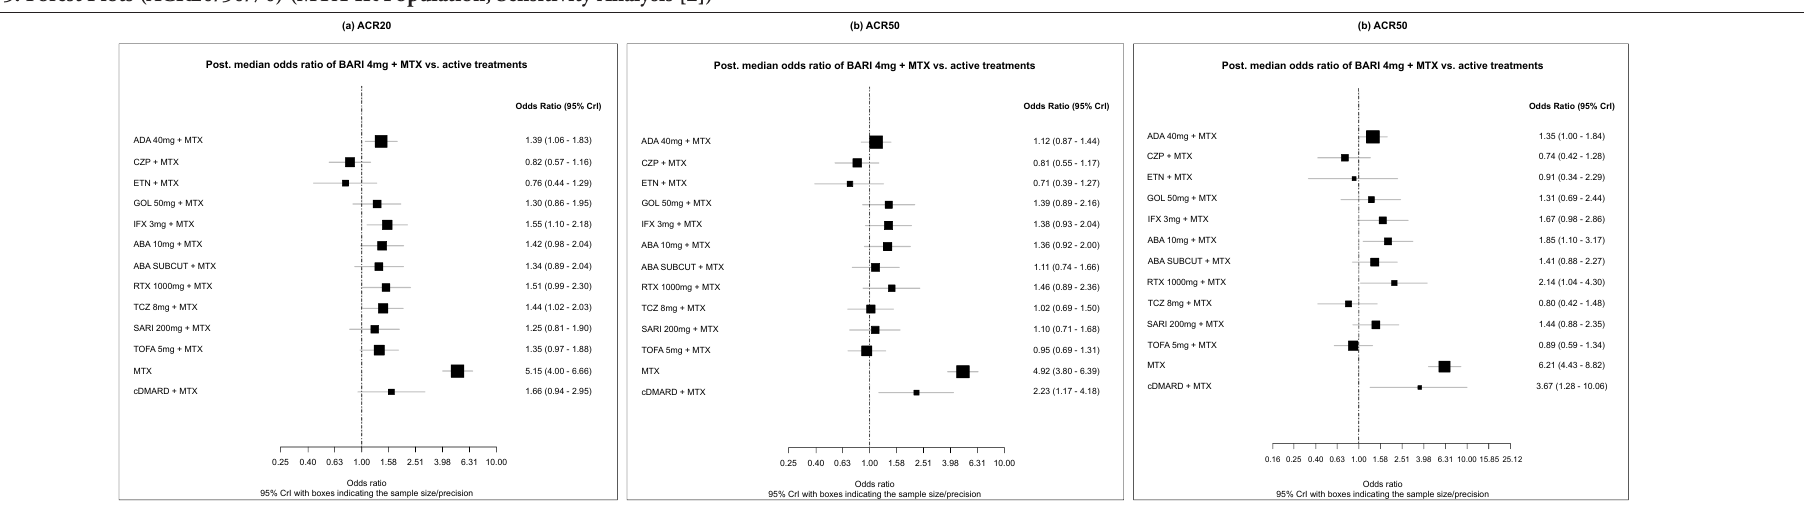
Odds ratios (ORs)presented refer to BARI 4 mg + MTX vs active treatments. Therefore, ORs >1 are in favor of BARI 4 mg + MTX, whereas ORs < 1 are in favor of the comparator. Sensitivity analysis (2): addition of trials allowing for up to 20% of patients with prior bDMARD use (29 trials for ACR20 and 28 trials for